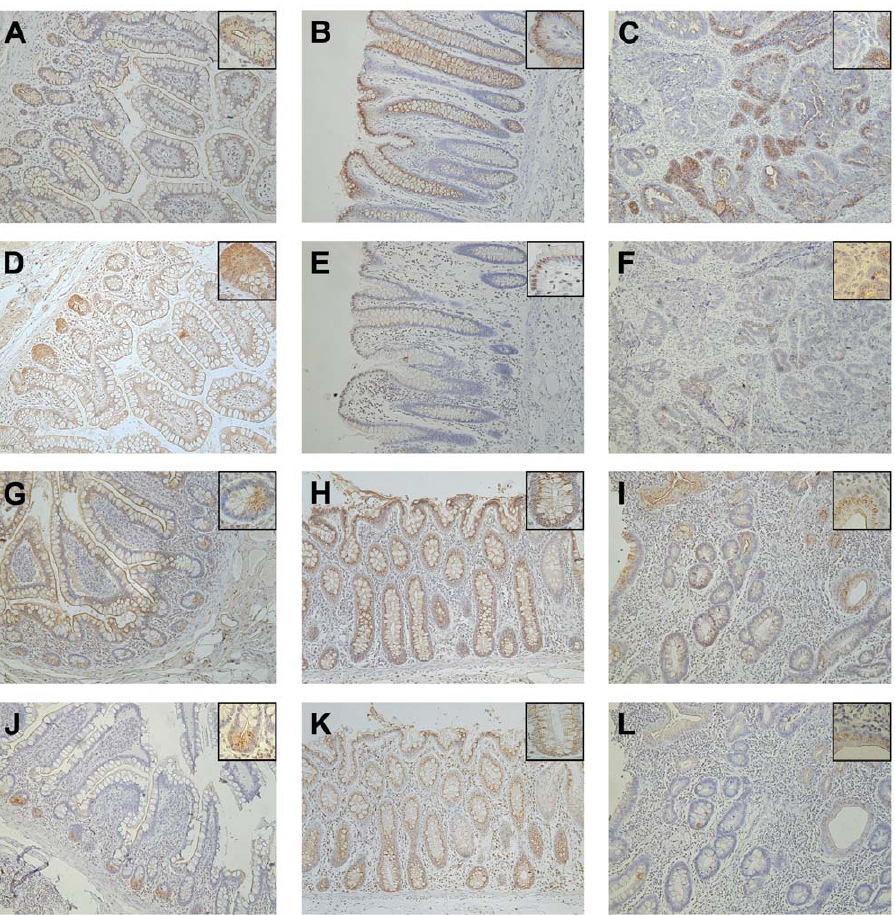
Figure 1. Positive staining for Fc e RI a -chain and defensin-5 is observed in serial sections from intestinal tissue. (A) Fc e RI a -chain is detected on the membrane, as well as in the cytoplasm of epithelial cells in small intestine of cancer patient No. 16. Fc e RI a -chain positive cells are also found in (B) the colon and (C) a tumor sample from the same patient. (D) Staining with anti-defensin-5 antibodies confirmed that Fc e RI a expressing cells at the basis of the small intestinal crypts are Paneth cells. Defensin-5 is expressed also in (E) colon and (F) tumor sample in same areas, but to a lesser extend when compared with Fc e RI a -chain staining. Similar staining pattern are observed also for the CD patient No. 8, as Fc e RI a -chain positive cells are detected in (G) the epithelium of small intestinal tissue, (H) colon and (I) lesional region. Defensin-5 positive cells are located at (J) the crypt basis of small intestine, (K) along the colon crypt, as well as in (L) the lesional region. Original magnification 6 10, inset 6 40. doi:10.1371/journal.pone.0009023.g001 permeabilized cells (Figure 6E). The expression levels decreased HCT-8 cells grown as multilayers with the new cells revealing a with confluency, as only a faint staining could be detected in the more immature phenotype, a scarce positivity was seen cytoplasma of confluent Caco-2/TC7 (Figure 6C) and HCT-8 (Figure 6H). cells (Figure 6G). No Fc e RI a positive staining was observed on the We could not detect Fc e RI b in any intestinal epithelial cell line membrane of confluent Caco-2/TC7 cells (Figure 6D). In the irrespective of the state of confluence (Figure 7A, D, G, J). In